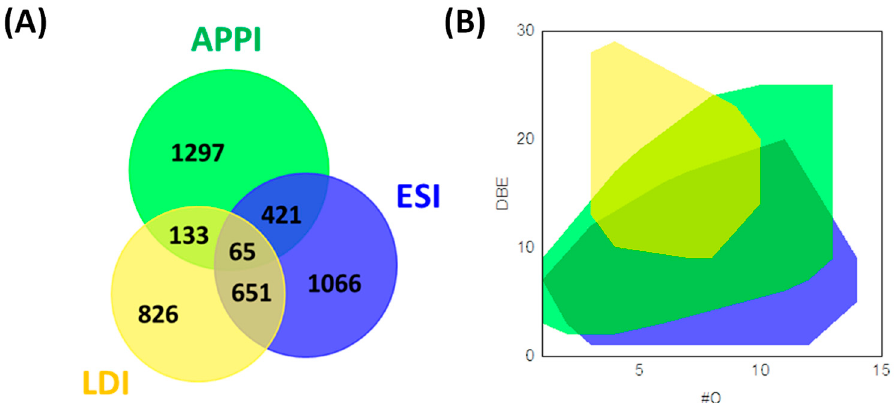
Figure 3. Venn diagram ( A ) and DBE vs. #O ( B ) of the CHO formulae obtained from ESI, APPI, and LDI FT-ICR MS analyses. The diagram was reprinted with permission from Ref. [17]. 2017 , Elsevier